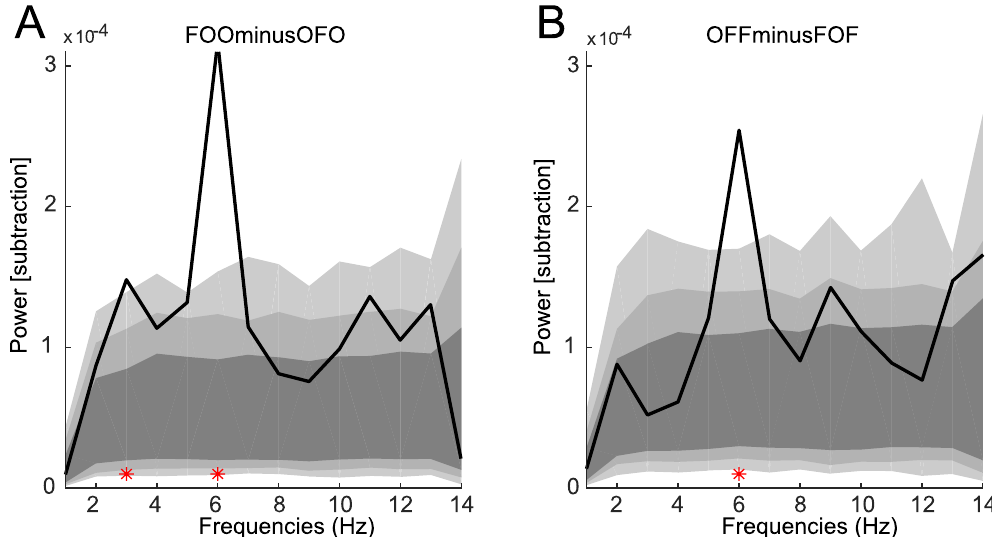
Figure 3. Frequency Analysis of the difference in RT time series between conditions with identical target location (FOO vs. OFO in A , OFF vs. FOF in B ). Light grey areas indicates the bootstrapped 99.9% CI (99% in darker grey, 95% CI in darkest grey). Red dots indicate frequencies with significantly higher power compared to a null hypothesis distribution calculated by randomizing the SOAs within opposing